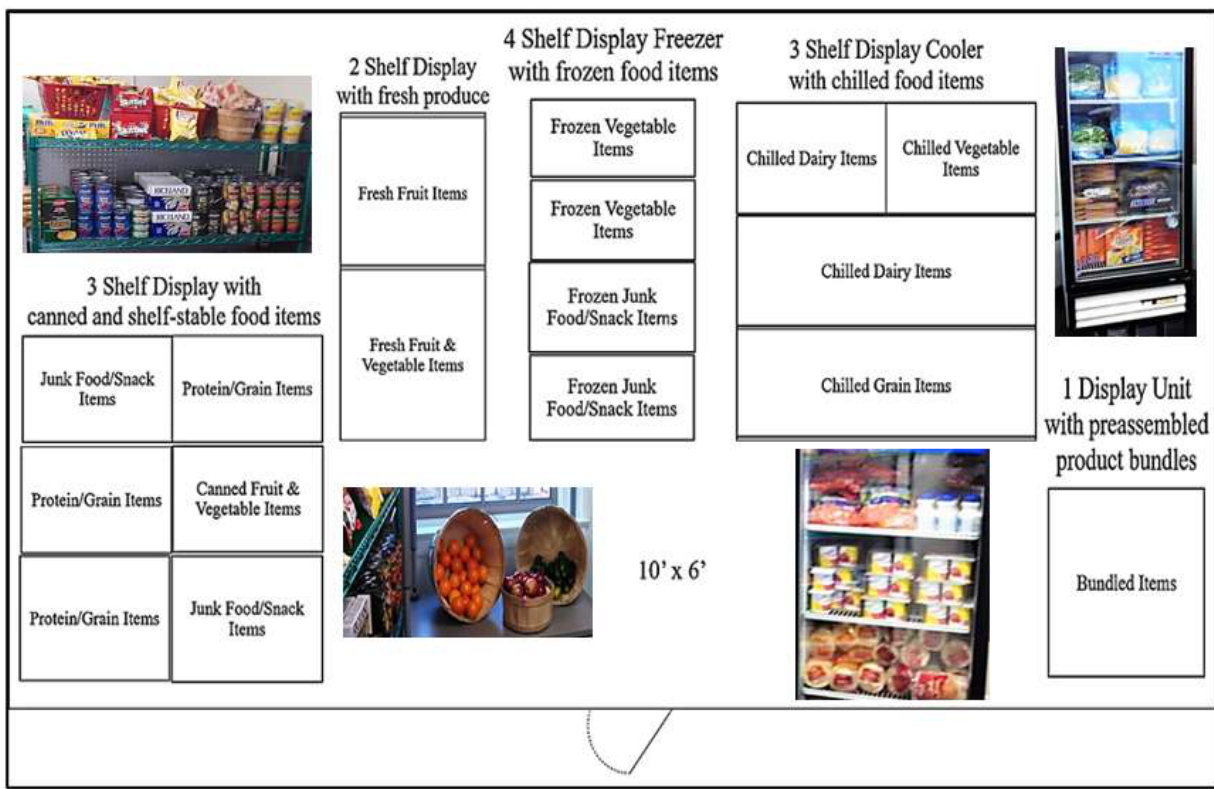
Figure 1. Display layout for the grocery shopping